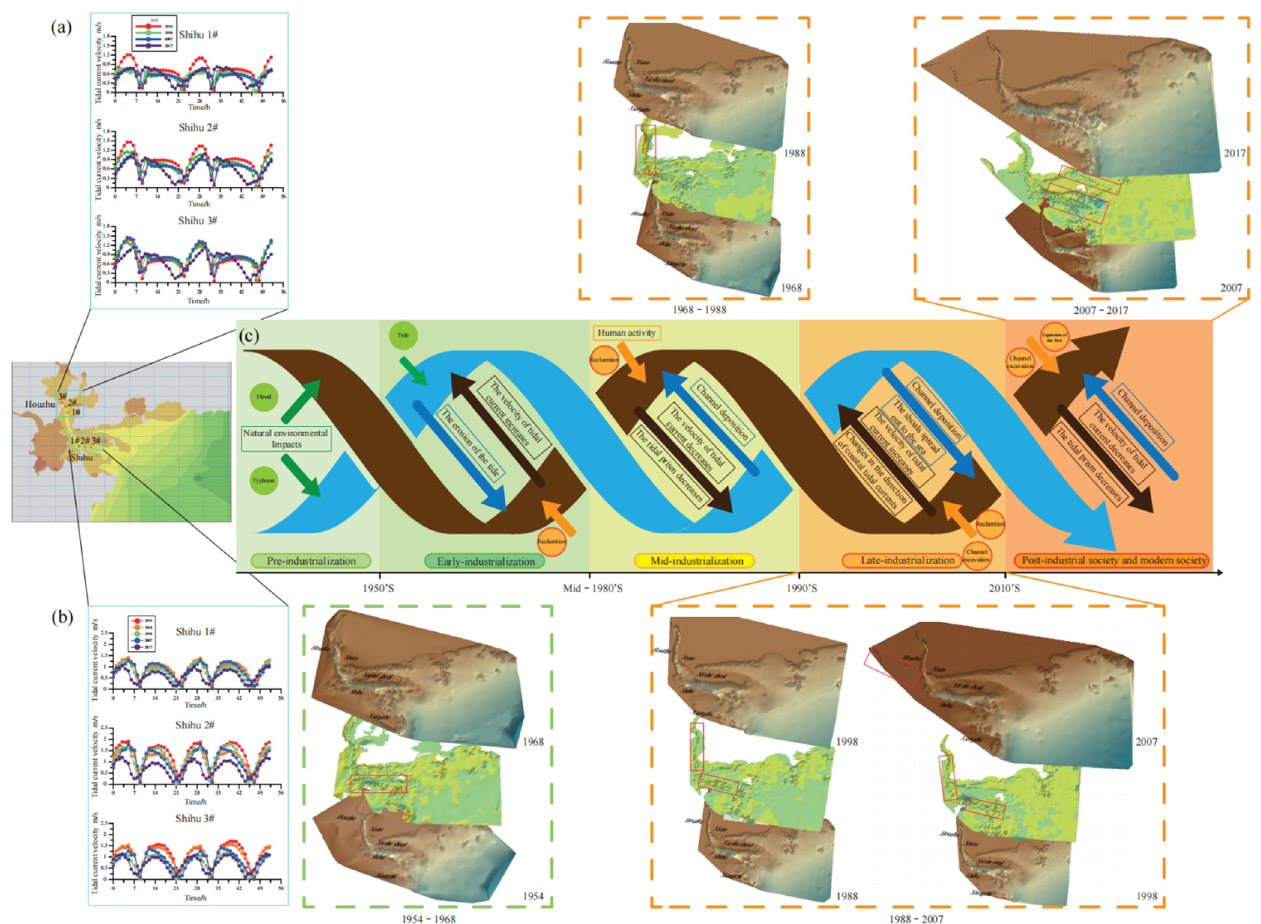
Figure 8. Coupled hydrodynamics and geomorphologic evolution in Quanzhou Bay. ( a ) Tidal currents in the Houzhu channel at different periods. ( b ) Tidal currents in the Shihu Port at different periods. ( c ) Coupling of geomorphologic changes and hydrodynamics in the Quanzhou Bay. The blue arrow shows the hydrodynamic development and the brown arrow shows the development and change of the bay geomorphology.